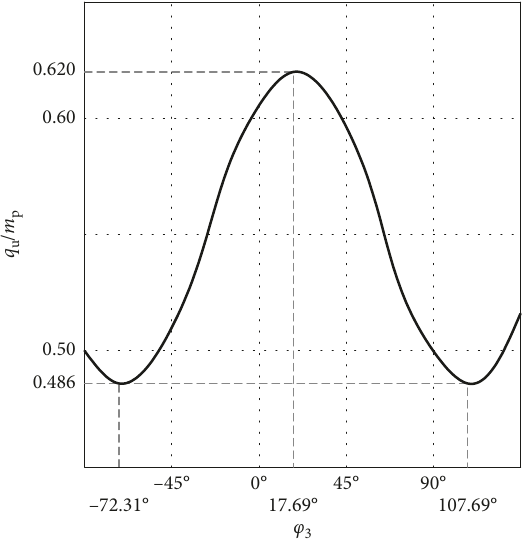
Figure 12: Variation of the q